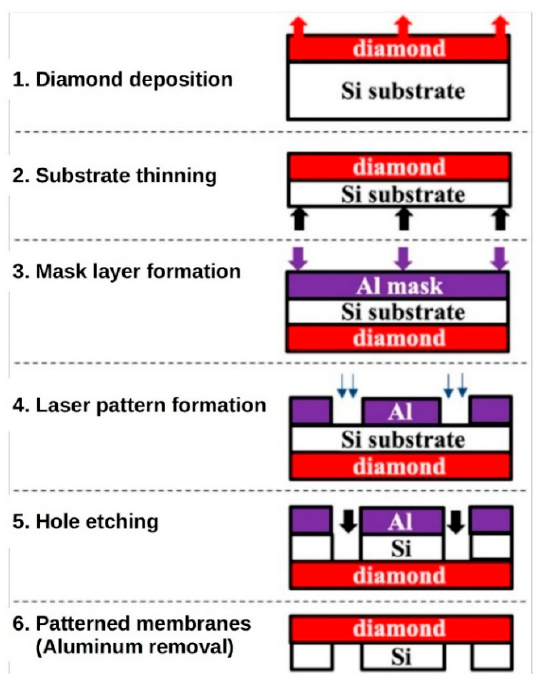
Figure 1. Scheme for the polycrystalline diamond membranes fabrication: (1) CVD growth of PCD films on Si substrate; (2) Thinning of the Si substrate with inductively coupled plasma etching; (3) Deposition of the thin aluminum mask; (4) Formation of windows in the Al mask using the excimer laser; (5) Local etching of Si substrate with the inductively coupled plasma etching technique; (6) Removal of the residual Al layer.